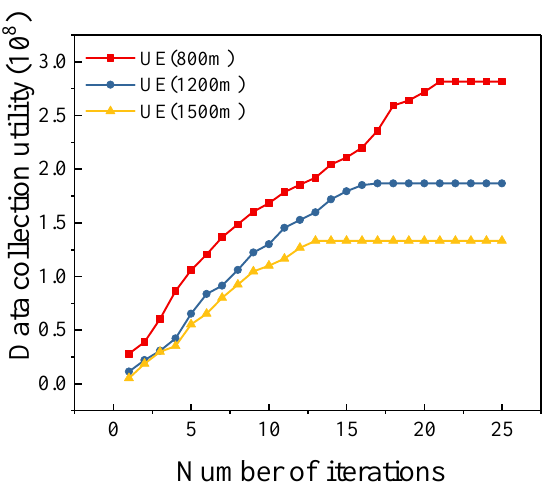
Figure 7. Convergence of UE Algorithm (800 m, 1200 m, 1500